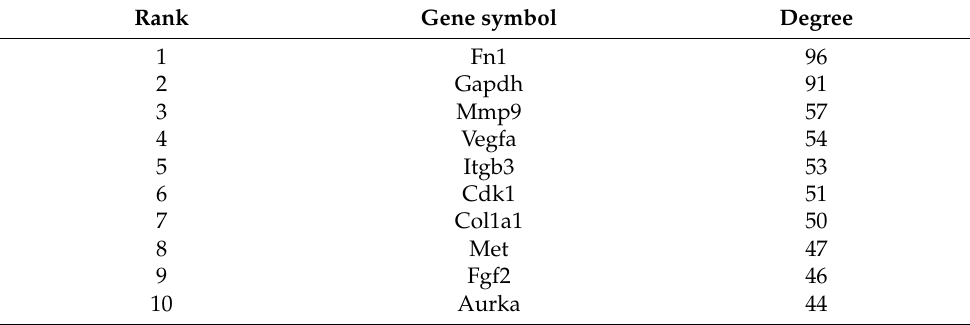
Table 2. The top 10 hub genes ranked by the connection